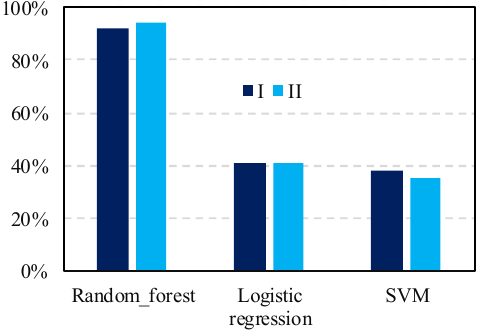
Figure 12. Precision rate of different methods in the real experiment.